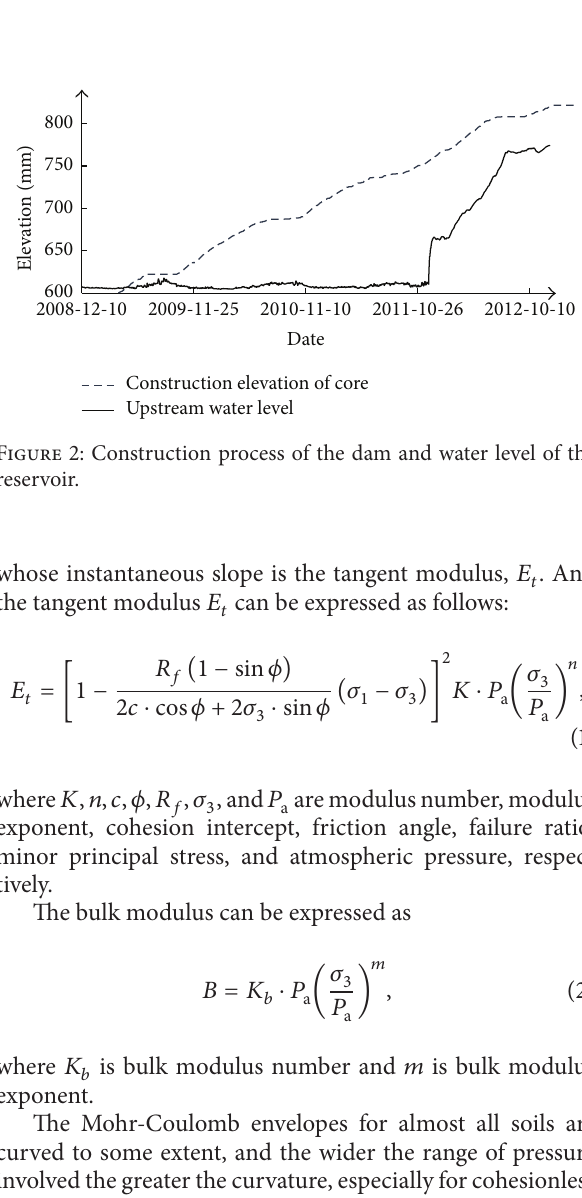
Figure 1: The maximum cross-section of Nuozhadu earth-core rockfill dam.